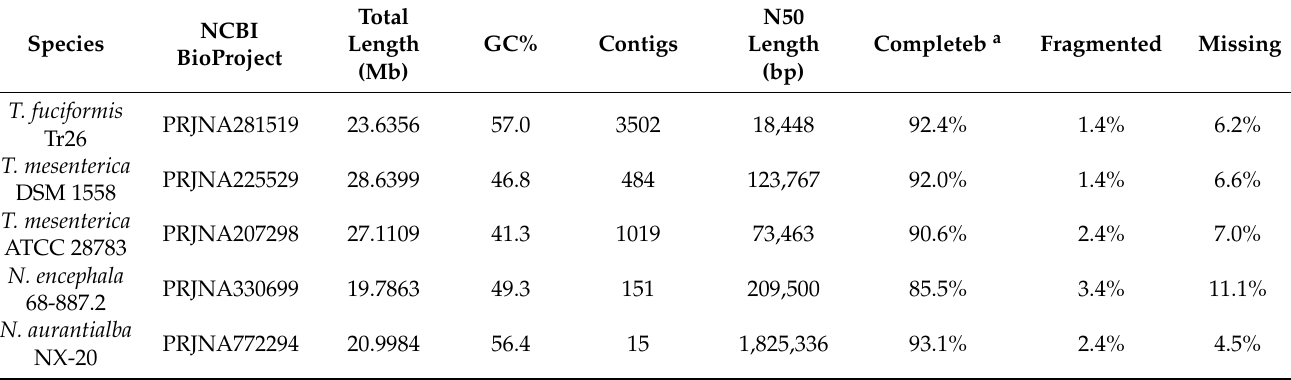
Table 2. Assembly summary statistics compared to other mushrooms of Tremellales.